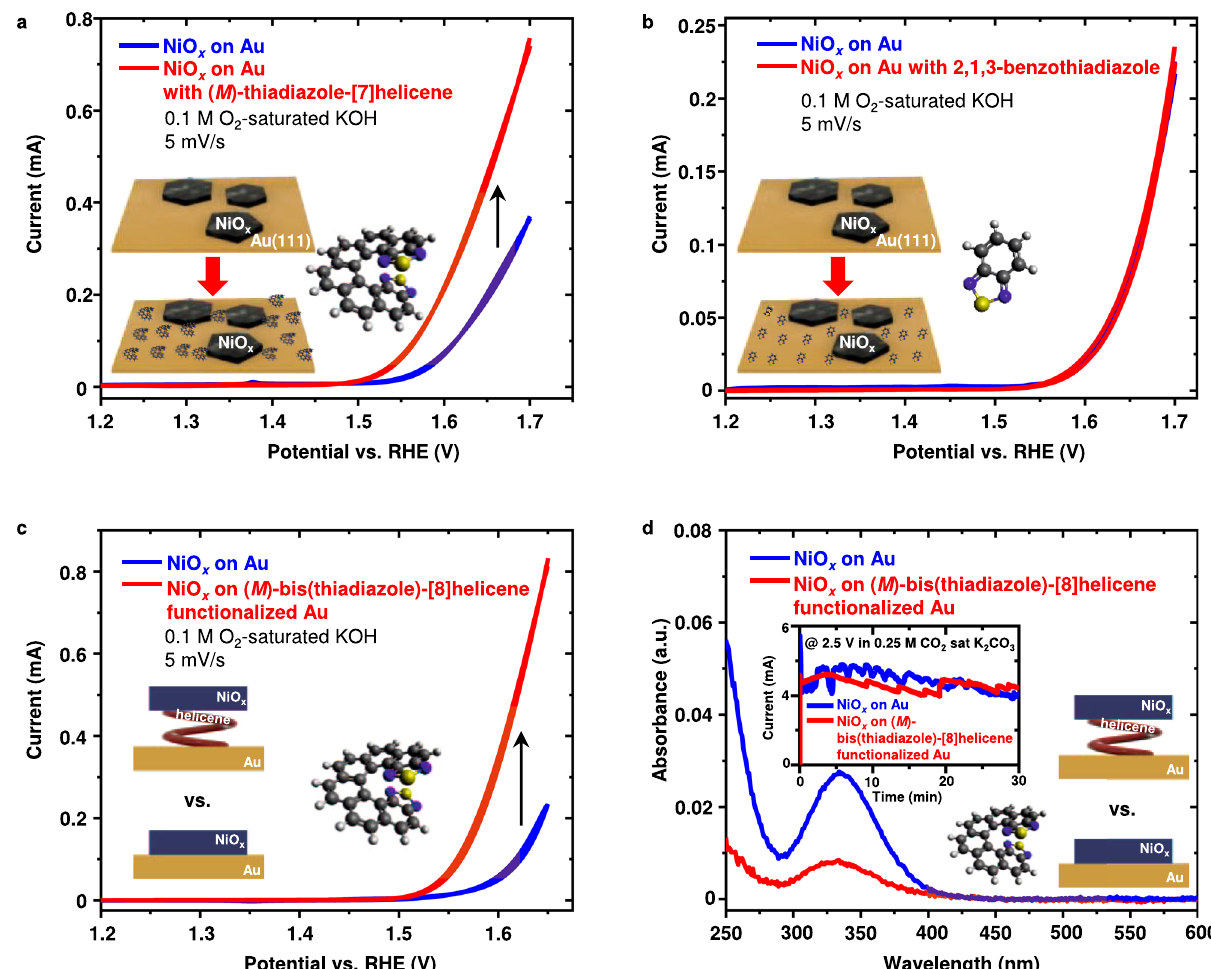
Fig. 3 OER activity of NiO x with chiral and achiral molecules and chiral molecular functionalization effect on the product selectivity. a , b OER activity of a ( M )-bis(thiadiazole)-[8]helicene on Au surface with NiO x , b 2,1,3-benzothiadiazole on Au with NiO x in 0.1 M O 2 -saturated KOH. c Comparison of OER activity of NiO x islands deposited on Au and NiO x islands deposited on Au with a monolayer of ( M )-bis(thiadiazole)-[8]helicene molecules. d UV-visible spectrophotometry analysis of H 2 O 2 production from chronoamperometry at 2.5 V vs. RHE (inset, see more details in Supplementary Fig. 6) at NiO x islands on Au and NiO x islands on Au with a monolayer of ( M )-bis(thiadiazole)-[8]helicene molecules. The absorbance spectra are normalized by the total charges transferred during the reaction. Source data are provided as a Source Data fi